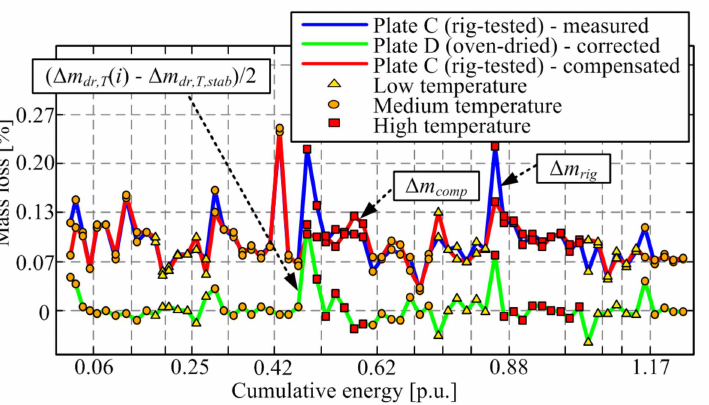
Figure 9. Illustration of compensation of mass loss response for rig-tested plate based on the oven- dried plate response with removed steady-state offset at each